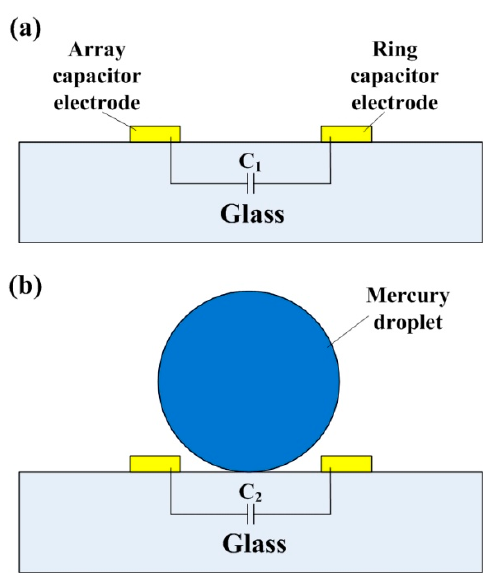
Figure 4. The schematic diagram of the mercury droplet and capacitors. ( a ) Droplet far away from capacitors, ( b ) droplet close to the capacitors.